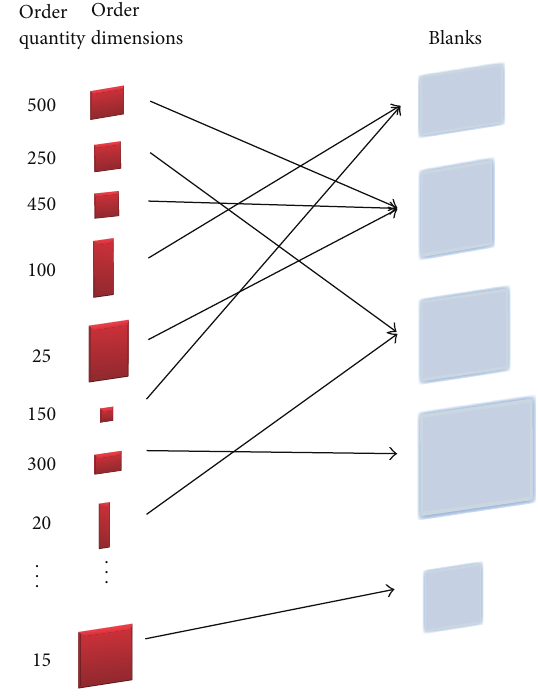
Figure 1: The mapping relationship of many orders to one blank.